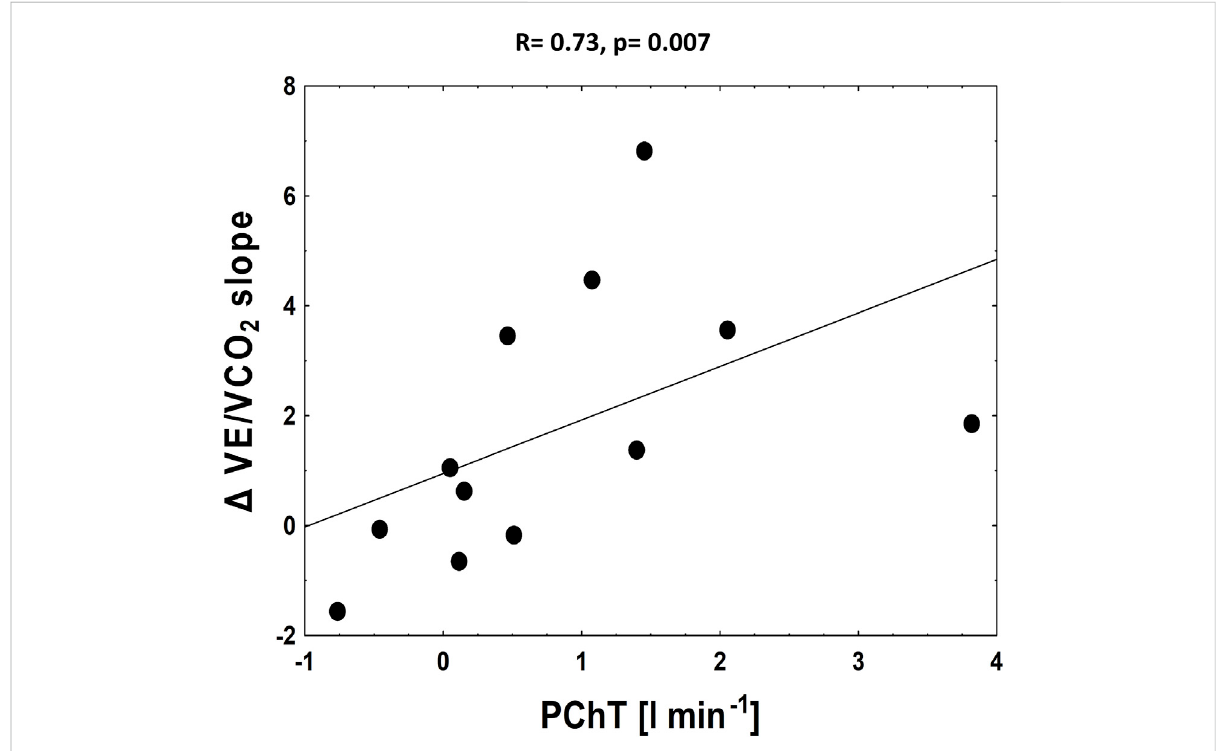
The correlation between absolute improvement in V _ E/V _ CO 2 slope and PChT (tonic activity).